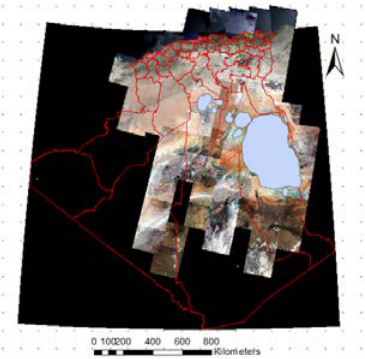
Figure 2. Determination of gas flaring polygons in Algeria using Landsat 8 images.